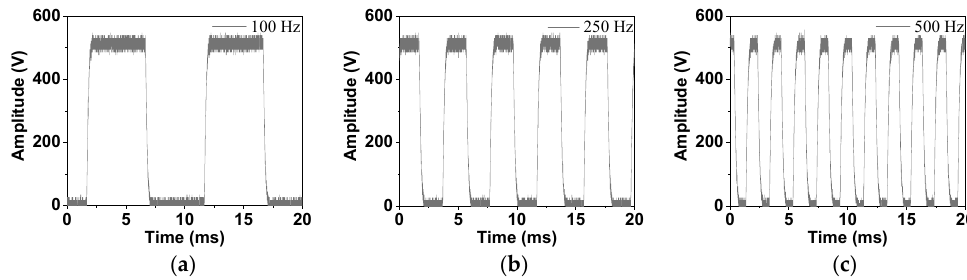
Figure 3. The voltages applied to the sample based on the improved circuit selection: ( a ) 100 Hz, ( b ) 250 Hz, ( c ) 500 Hz.